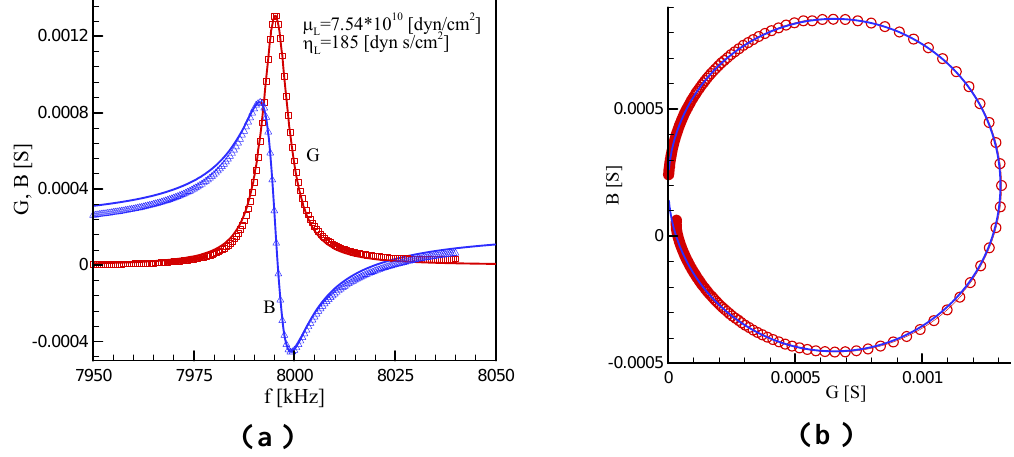
Figure 5. Comparison between calculated (lines) and measured (symbols) conductance (G) and susceptance (B) at T = 83 [ ° C] (a) in the ƒ – G and ƒ – B planes; (b) in the G – B plane (Nyquist plot).